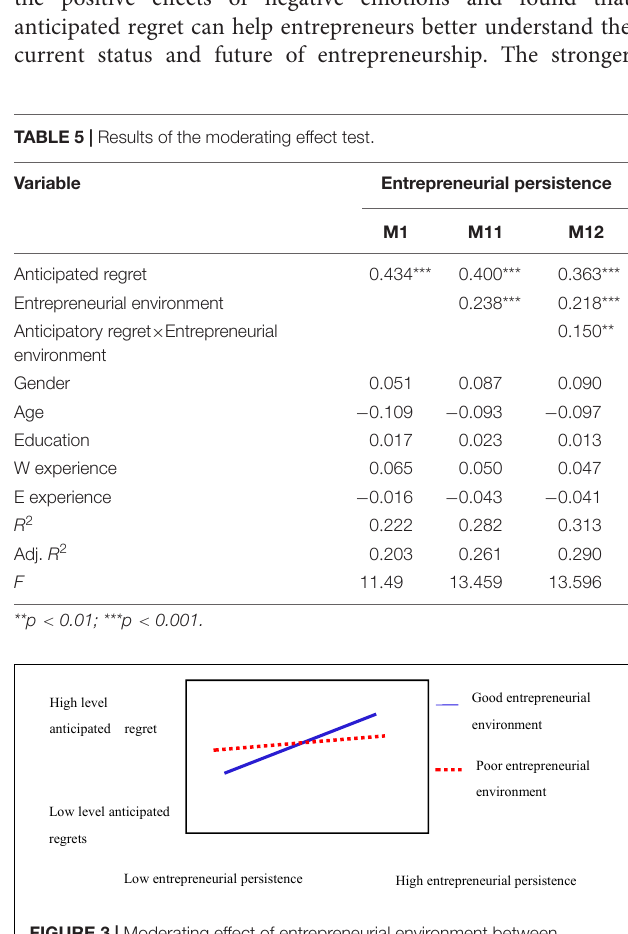
FIGURE 3 | Moderating effect of entrepreneurial environment between anticipated regret and entrepreneurial